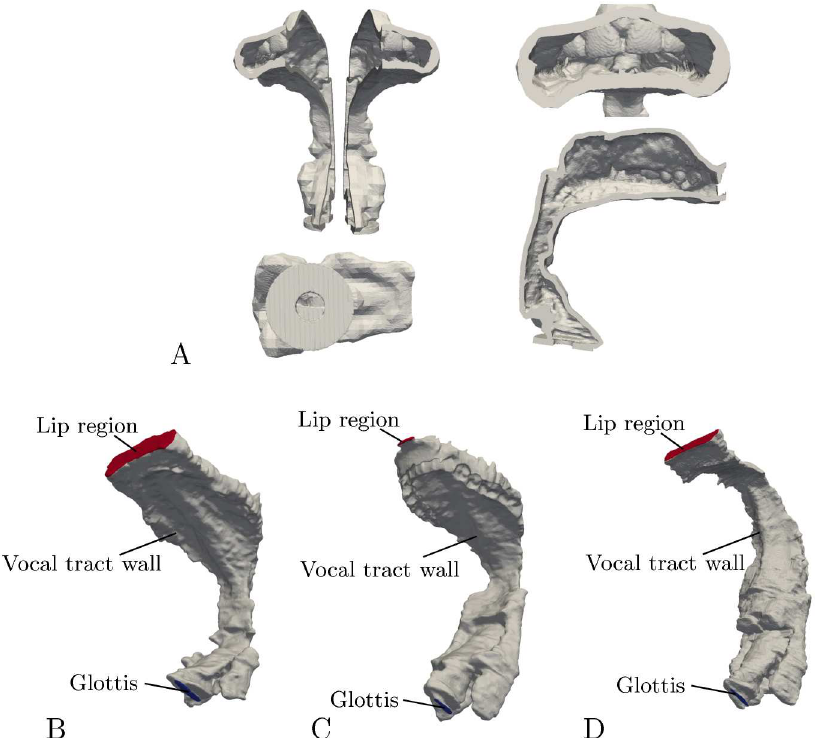
Fig 3. Printed and finite element models. (A) Different views of the 3D-printed model of /a/. (B), (C) and (D) Finite element models of /a/, /u/ and /i/. For each model, the surface was partitioned into three regions representing the glottis, the lip region and the vocal tract